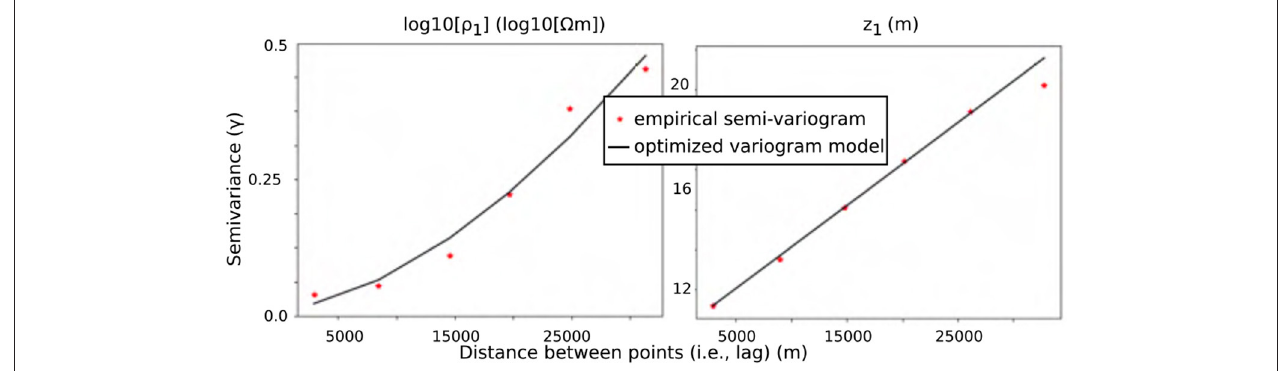
FIGURE 5 | Example of experimental and modeled semi-variogram for the first layer resistivity ( ρ 1 ) and depth to the bottom ( z 1 ) of the sector Limarí river upstream of Altos de Talinay.